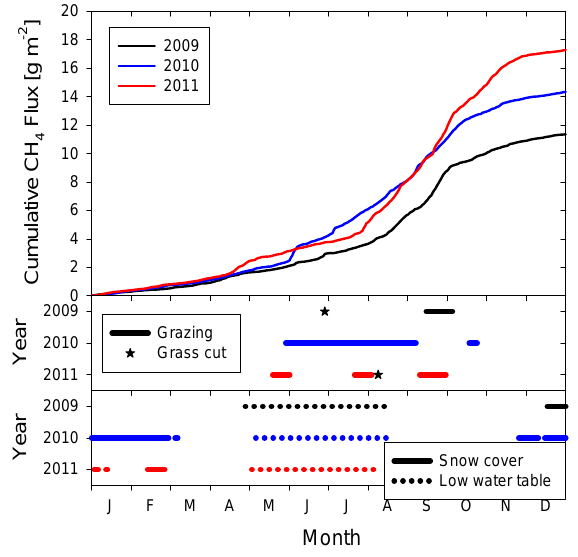
Fig. 4. Same as Fig. 3 but for CH 4 instead of CO 2 .